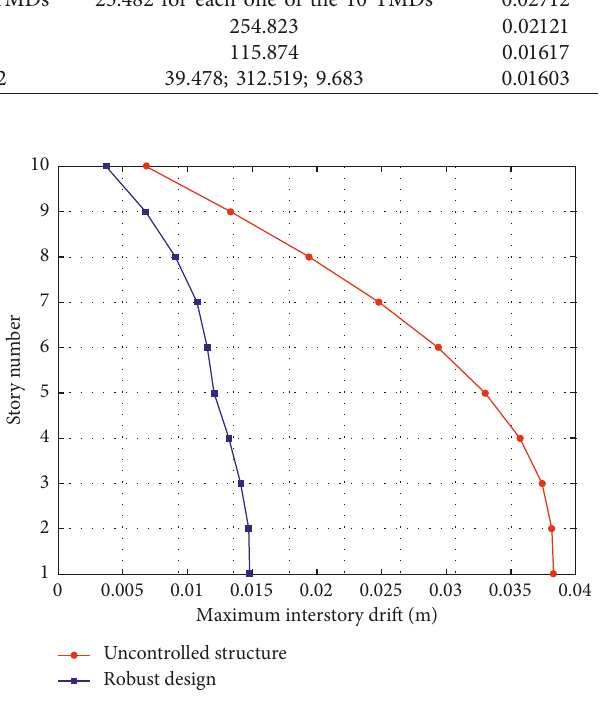
Figure 3: Maximum interstory drift per story for uncontrolled structure (red curve) and controlled structure (blue curve), for coefficient of variation equal to zero for all parameters. Table 5: Comparison between maximum interstory